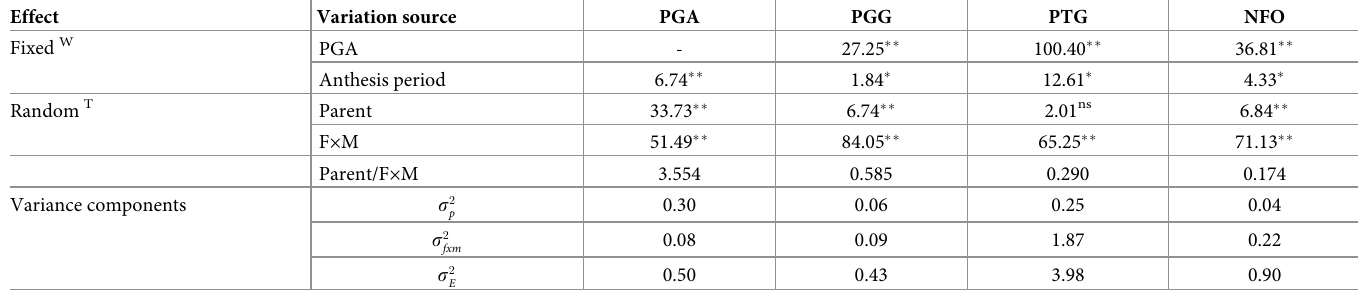
Table 4. Likelihood ratio test for fixed effects and random effects (estimated via REML/BLUP for parent and female-male interaction (F × M) effects) on the number of pollen grains that adhered to the stigma surface (PGA), the number of pollen grains that germinated on the stigma surface (PGG), pollen tube growth (PTG), and the number of fertilized ovules (NFO) evaluated for crosses between 21 cassava parents.